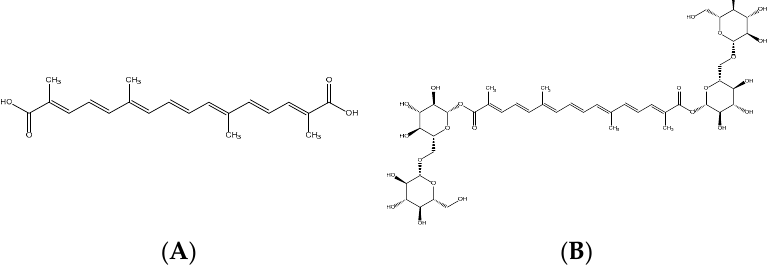
Figure 8. Structures of crocetin ( A ) and crocin ( B ).